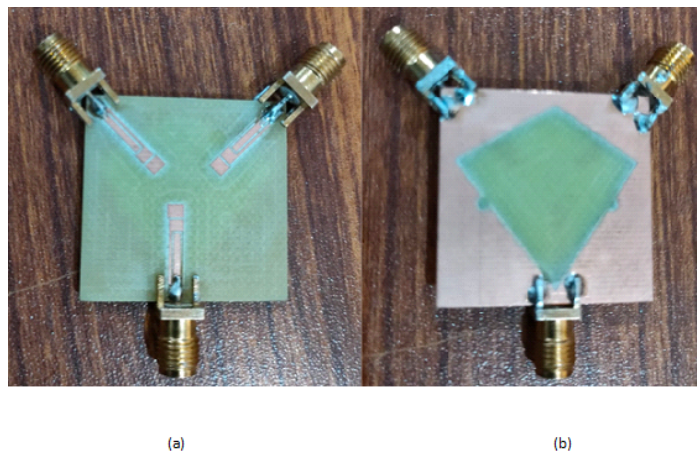
Figure 13. Prototype of proposed Kayi-shaped UWB-MIMO antenna: ( a ) front view (Kayi-shaped) where each radiator includes two notching elements to create two notch bands where the third notching band is created by the mutual coupling of the existing notching elements; and ( b ) back view (Kite-shaped) loaded with two semi-circles to attain larger impedance matching.